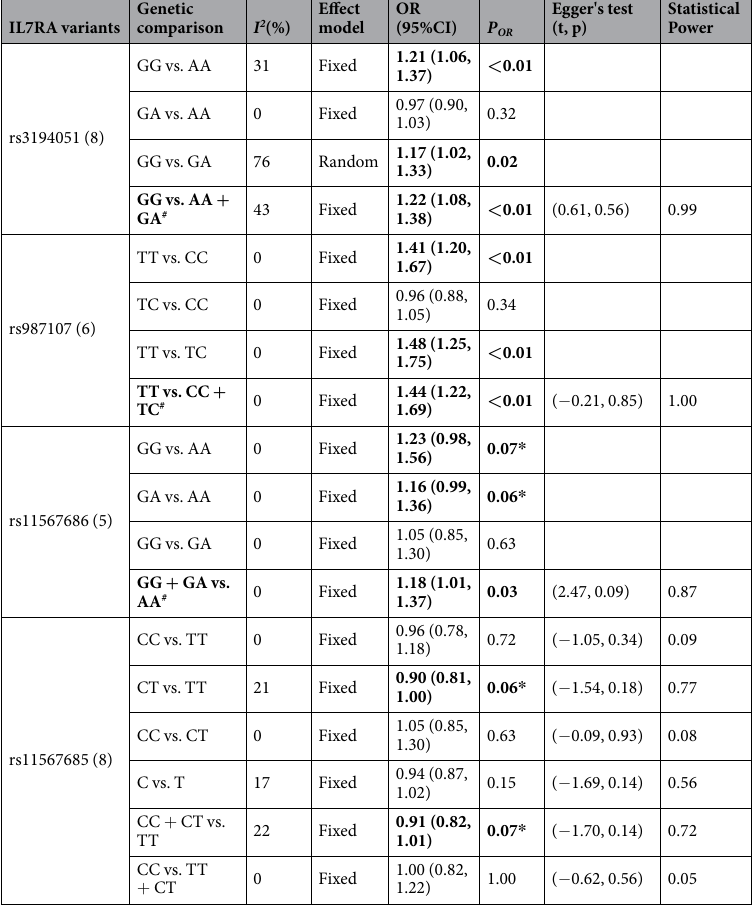
Table 4. Meta-analysis of IL7RA polymorphisms on MS. Note: bold: significant P -value ( < 0.05); bold * : marginal association (0.05 < P -value < 0.1); # Suggested